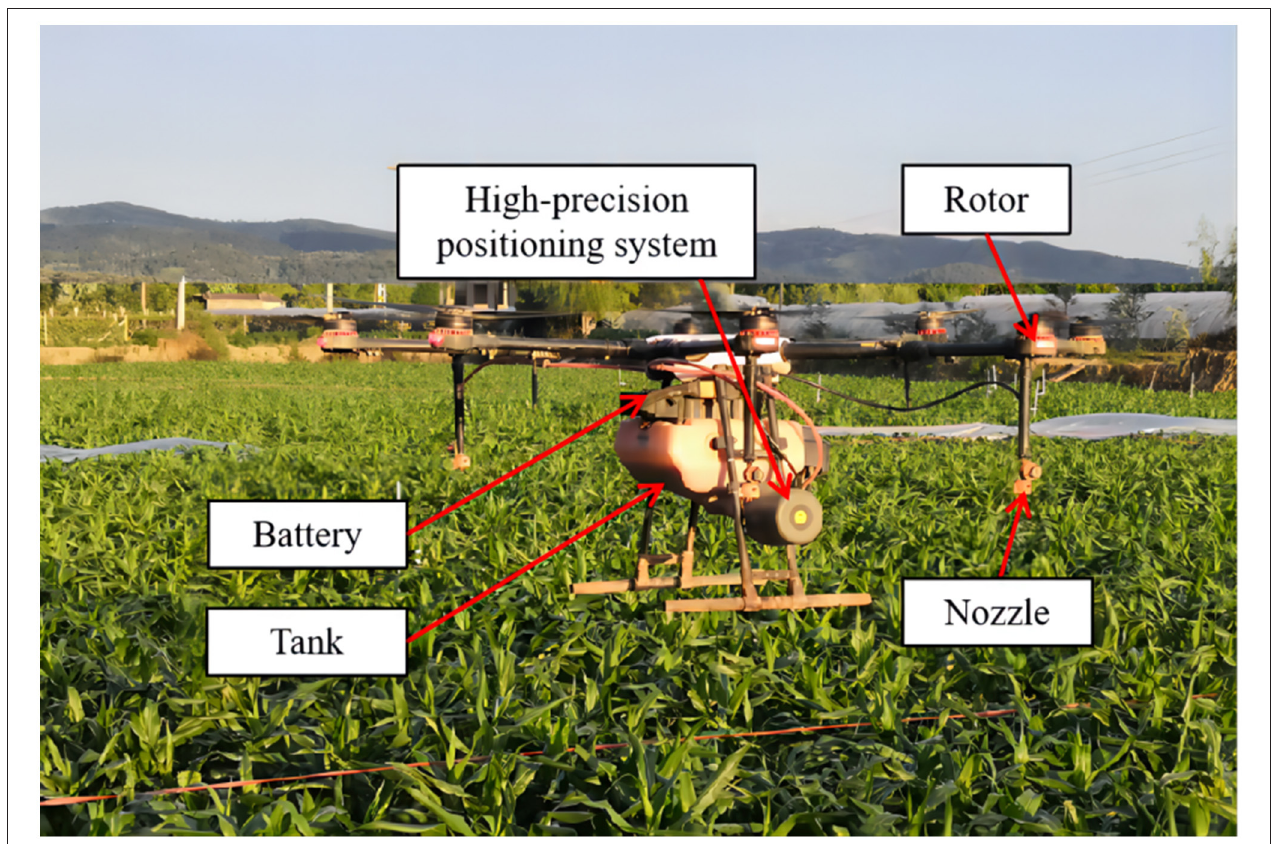
FIGURE 1 | The DJI MG-1P eight-rotor electric unmanned aerial spray system (UASS).